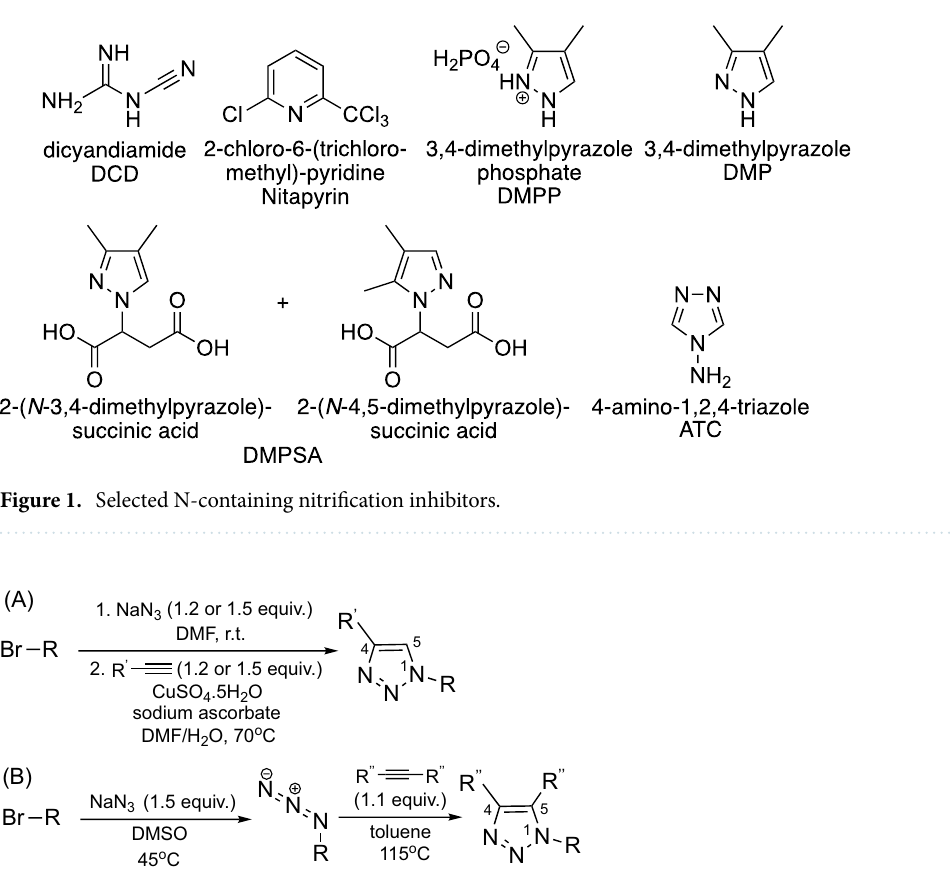
Figure 2. Synthetic pathways to the 1,2,3-triazoles studied in this work: ( A ) Cu(I) catalysed azide alkyne click reaction to give 1,4-disubstituted 1,2,3-triazoles; ( B ) thermal Huisgen 1,3-dipolar cycloaddition of an azide